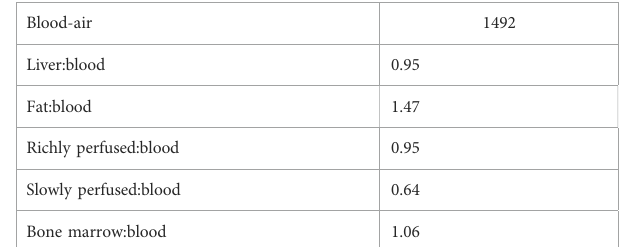
TABLE 1 3-CAA partition coef fi